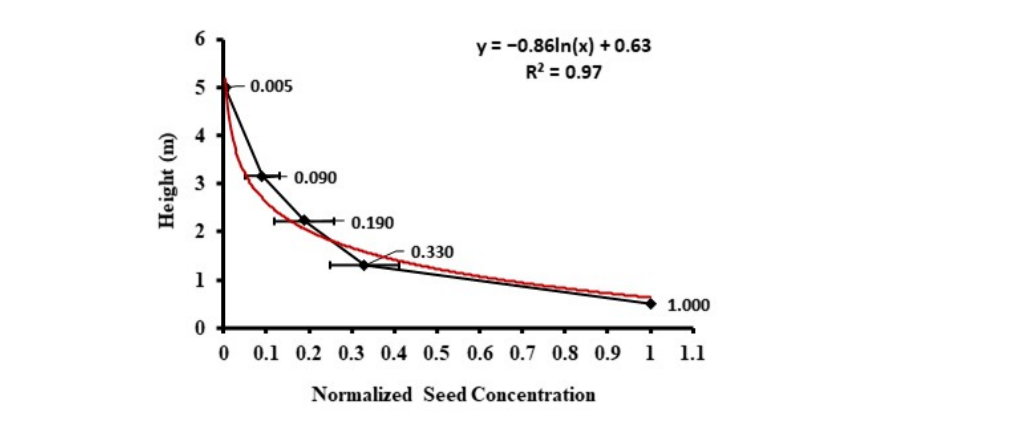
Figure 5. Vertical distribution of normalized seed concentration between the height of 0 and 5 m in the Tennessee field (normalized by the concentration at the center of the field at 0.5 m height). The diamonds are means, and the bars are standard deviations.